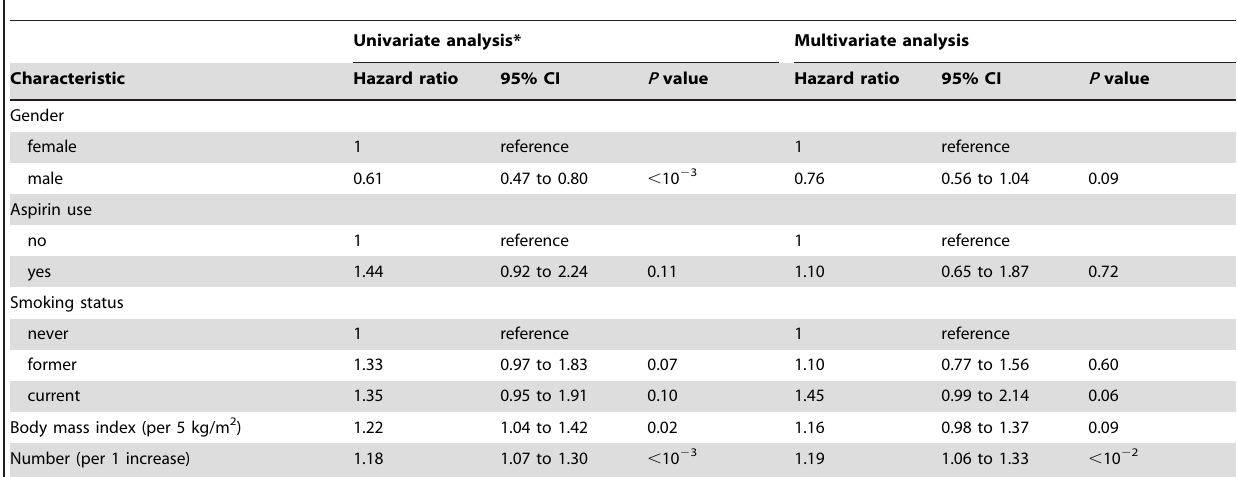
Table 4. Hazard ratios for polyp recurrence, according to baseline patient and polyp characteristics (553 followed up participants).